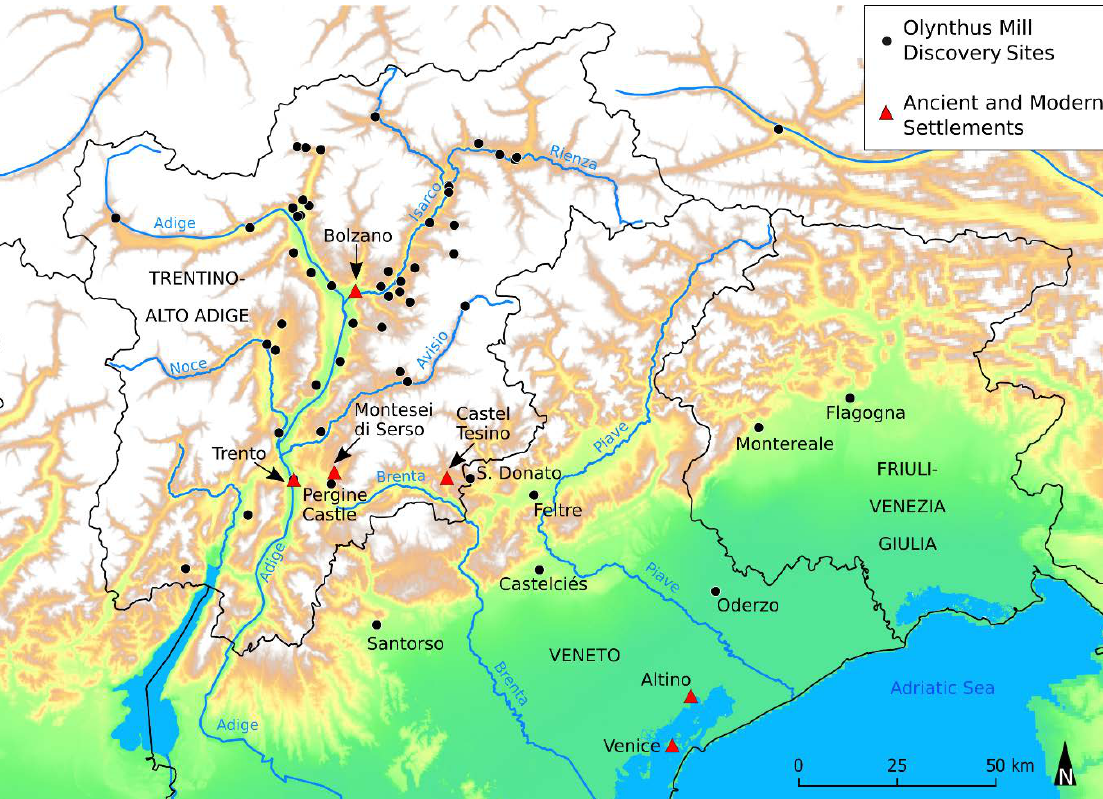
Figure 7. Olynthus mill discovery sites in northern